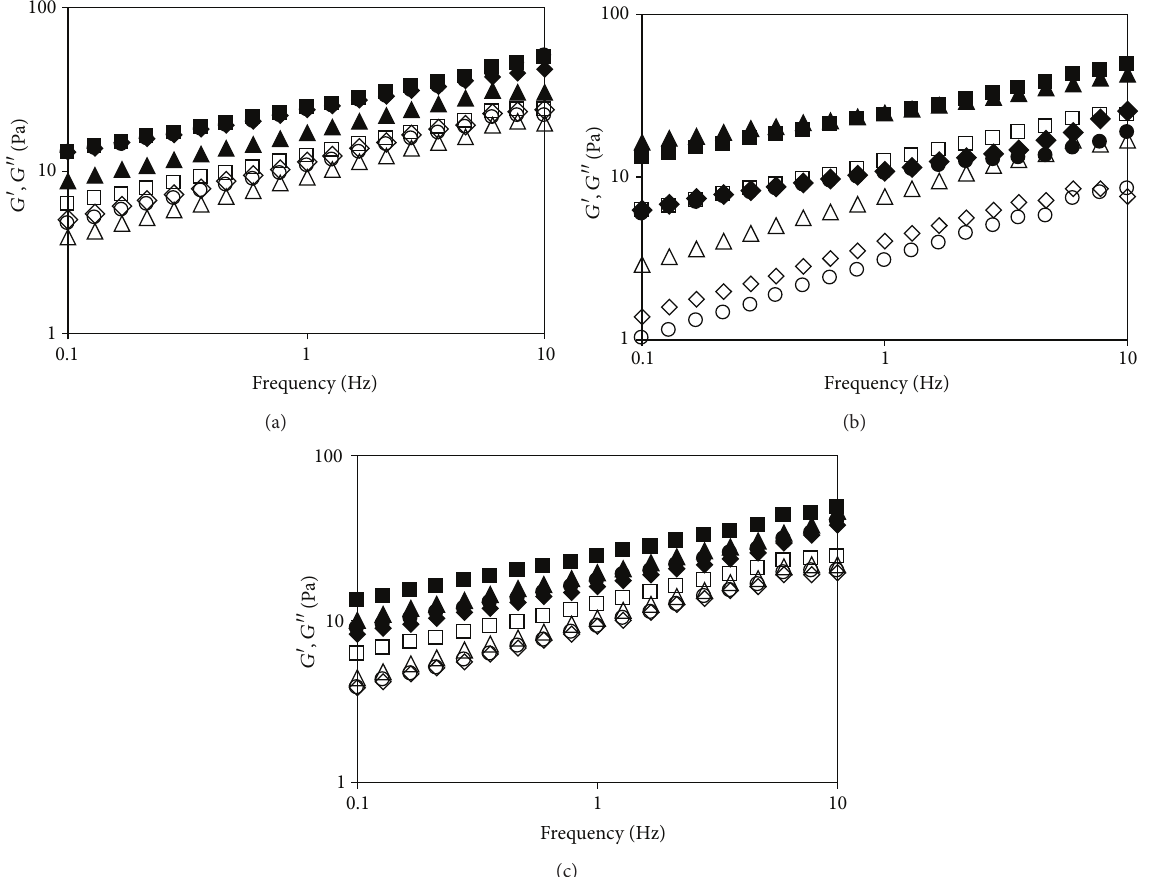
Figure 3: Mechanical spectra ( 𝐺 󸀠 : black markers, 𝐺 󸀠󸀠 : white markers) of native starch and blends with (a) low-saccharified maltodextrin, (b) medium-saccharified maltodextrin, and (c) high-saccharified maltodextrin. Maltodextrin concentration: 0— ◻ , 1— 󳵻 , 2— ◊ , 3— I